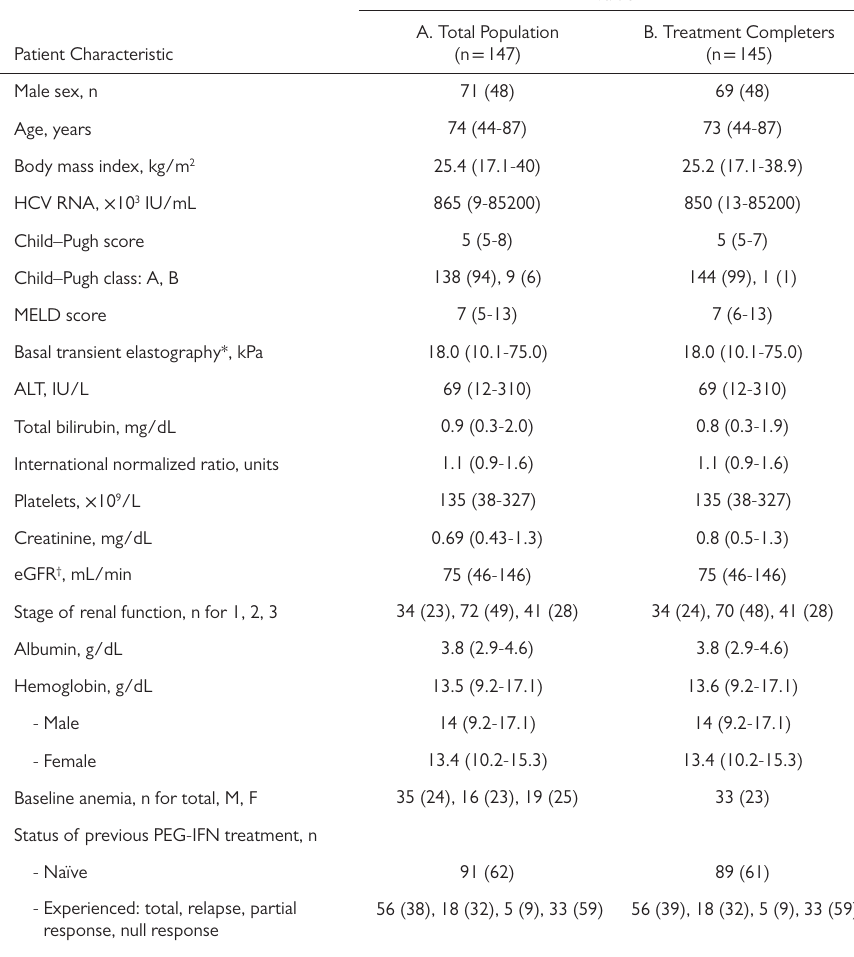
Table 1. Main Baseline Demographic and Clinical Features of the Studied Population